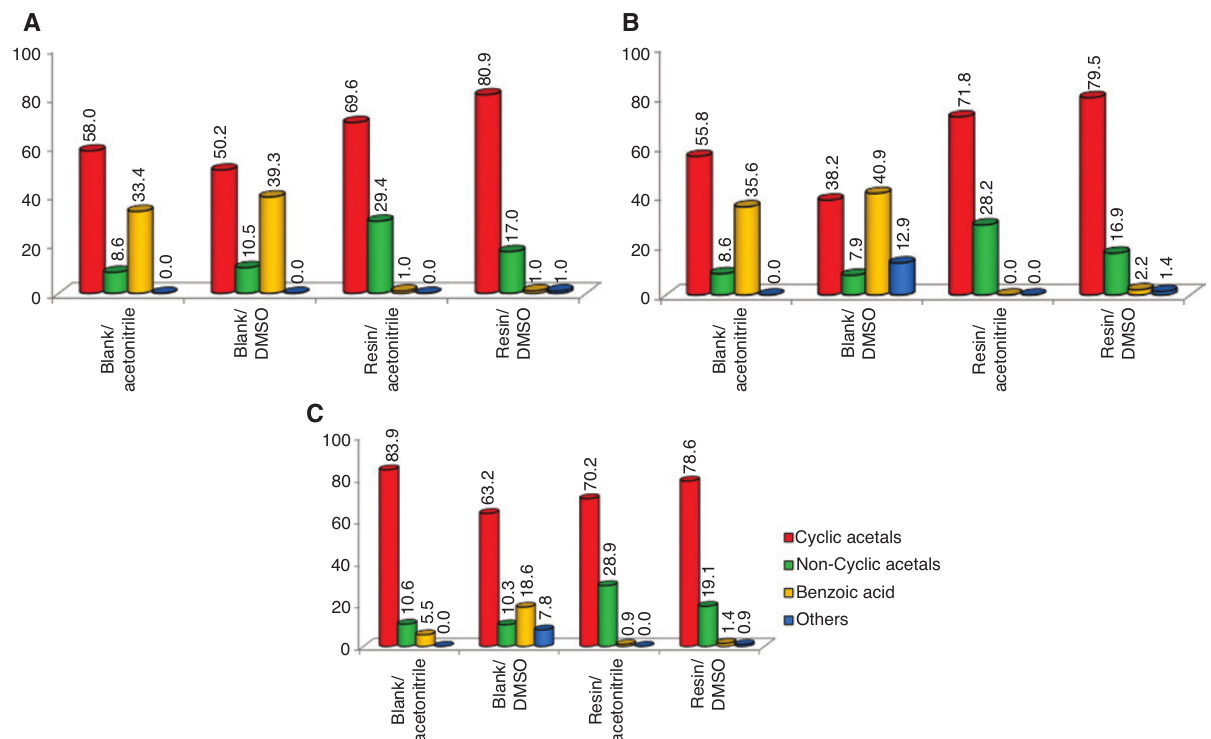
Figure 6: Selectivity (%) comparison ratios versus organic solvents about the main products of the glycerol etherification with benzaldehyde. (A) Gly/Bz ratio (1:1), (B) Gly/Bz ratio (1:2), and (C) Gly/Bz ratio (2:1). Errors deviation in 0.7–2.5%.